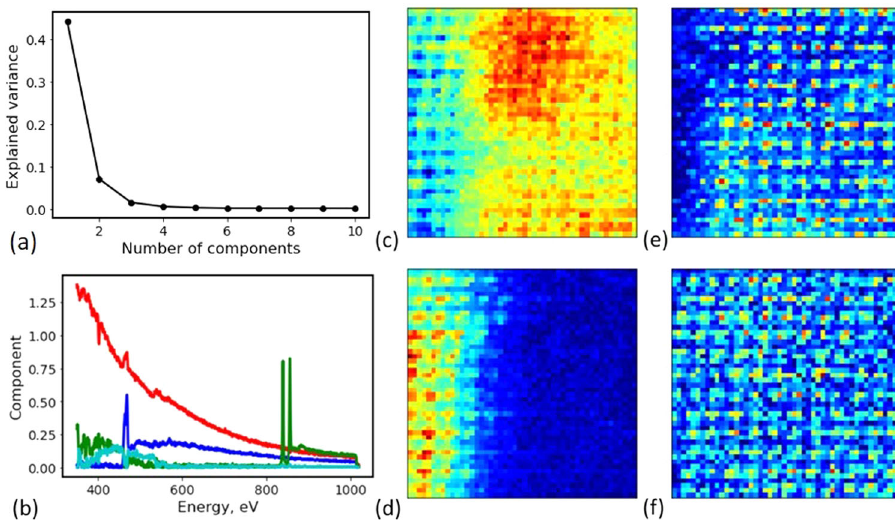
Fig. 1 Exploratory data analysis. a PCA scree plot of EELS data set. b First four NMF components (red — 1st, blue — 2nd, green — 3rd, and cyan — 4th) and c – f fi rst four NMF loading maps. The color maps in c – f are normalized to (0,